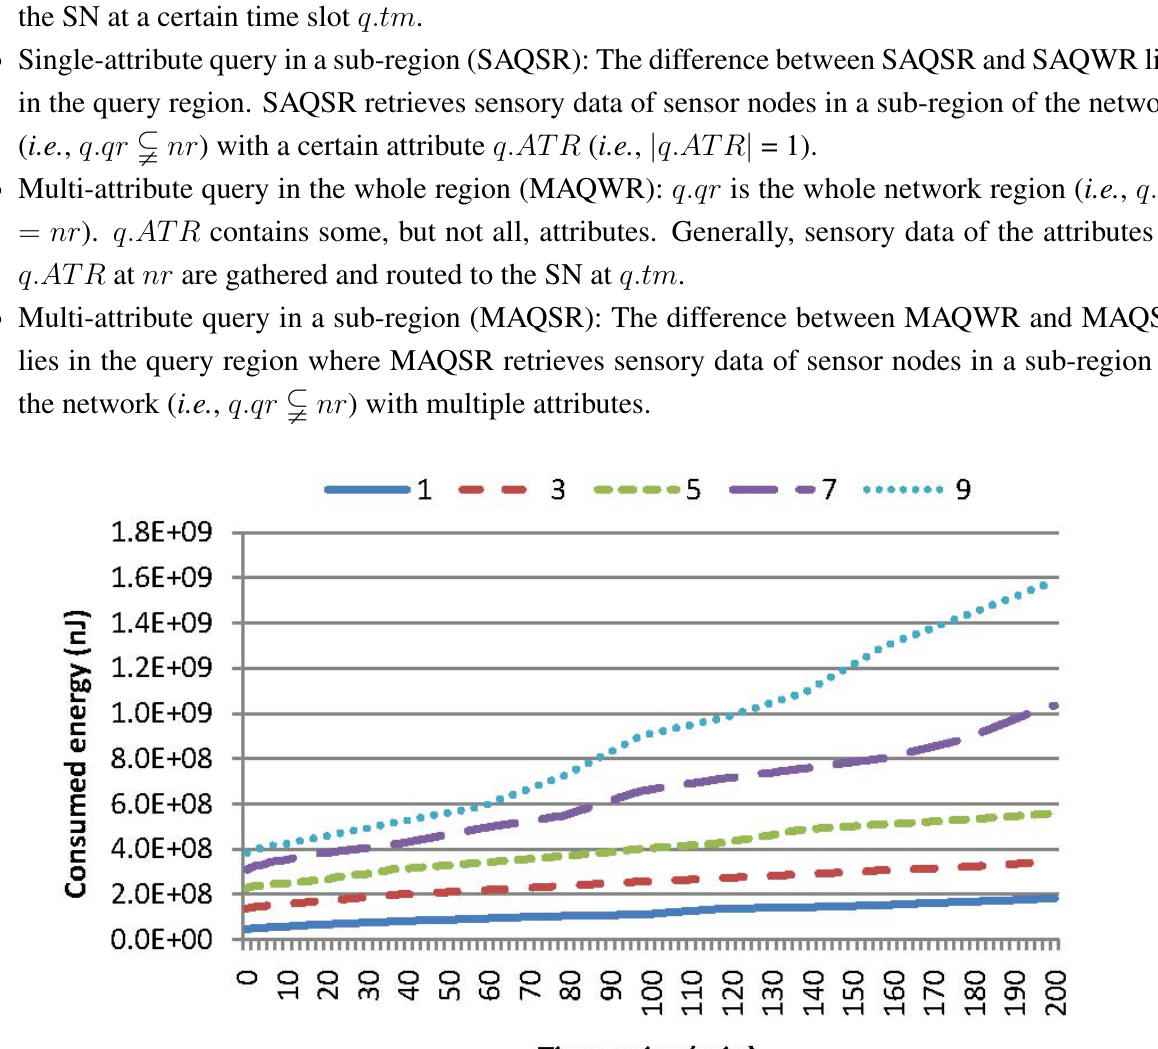
the SN at a certain time slot q.tm .